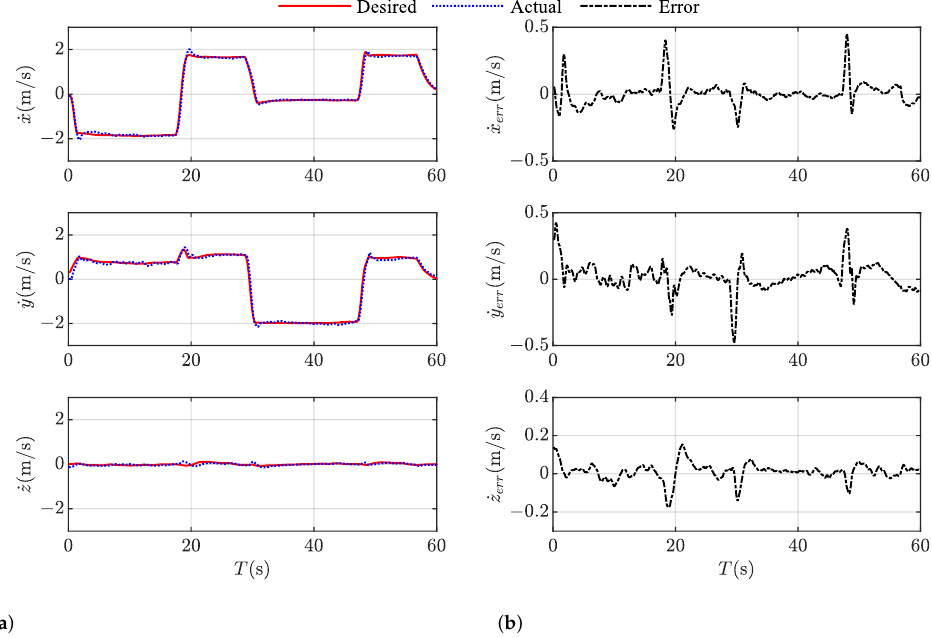
Figure 18. Velocity tracking during flight: ( a ) velocity tracking response; ( b ) velocity tracking